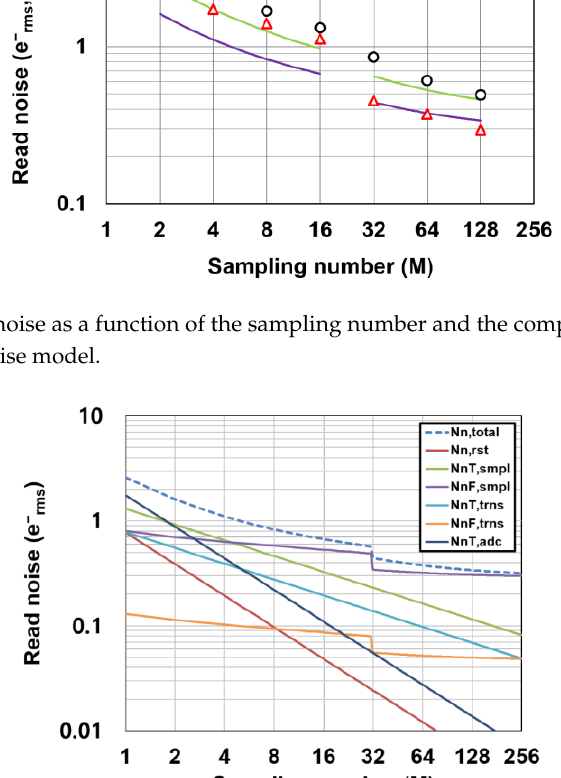
Figure 14. Noise components as a function of the sampling number in the folding-integration ADC. Table 2. M , M G and T H-READ used in the